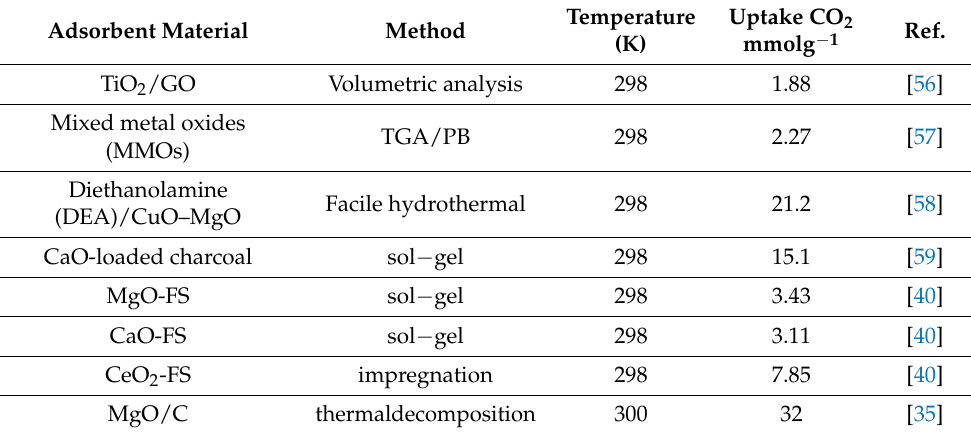
Table 2. Summary of CO 2 absorption studies, using different metal oxides at low temperatures. Adsorbent Material Method